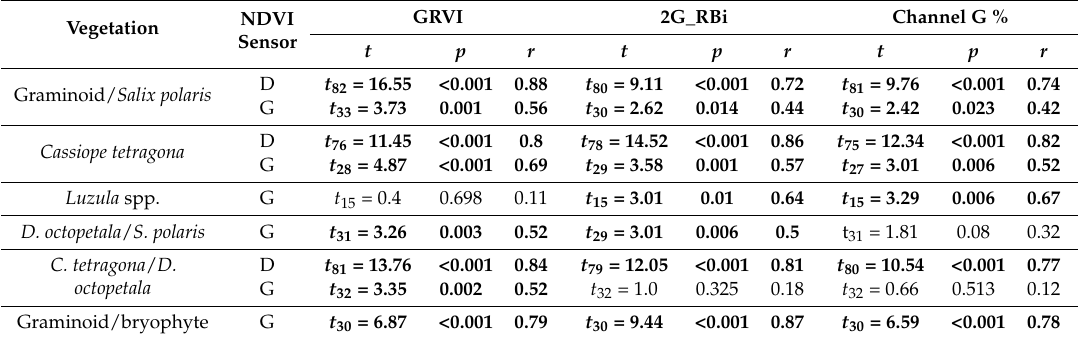
Table 1. Pearson’s correlations between NDVI and three different RGB greenness indices in six different High Arctic vegetation types. The NDVI measurement instruments used were Decagon sensors (D) and a Greenseeker device (G). Greenness index values outside the 95% confidence interval of the linear model have been omitted from the analyses to exclude obviously erroneous data. t = t -statistic t n = the valid sample numbers after filtering the time serial data. Statistically significant relationships are highlighted in